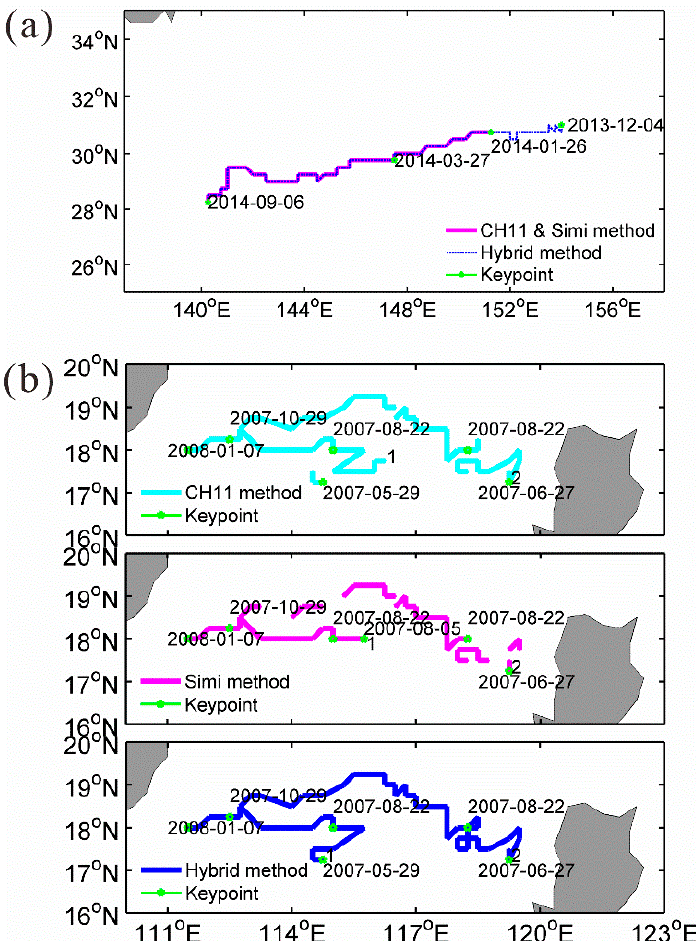
Figure 5. ( a ) For a reported Western Pacific eddy, the CH11 and similarity methods produce the same track (magenta line), while the hybrid method tracks the eddy for a longer period of time (blue dotted line). The green star denotesthe milestone points along the track. The dates are as follows: “2013-12-04” denotes where and when this eddy formed and the beginning of the hybrid method tracking,“2014-01-26” denotes the point at which the CH11 and similarity tracking began,“2014-03-27” denotes where and when the 17 Argo floats were deployed, and “2014-09-06” denotes when and where the tracking ended; ( b ) Tracking results of the three algorithms for eddies reported in the South China Sea. Numbers “1” and “2” represent two eddies named Eddy1 and Eddy2. Eddy1 was tracked using the hybrid method from “2007-05-29” to “2007-10-29”, and Eddy2 was tracked from“2007-06-27” to “2008-01-07”. This result is consistent with former validated work. The other two methods resulted in different tracks along the eddy paths.